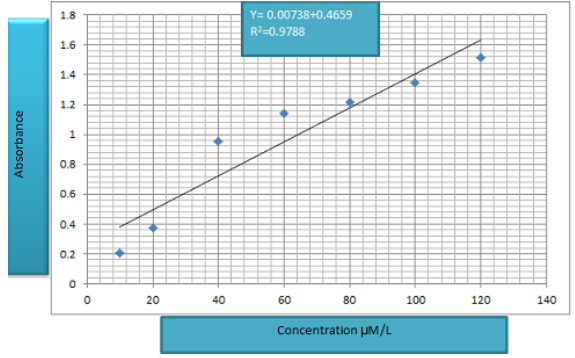
Figure, 1: Standard curve of different